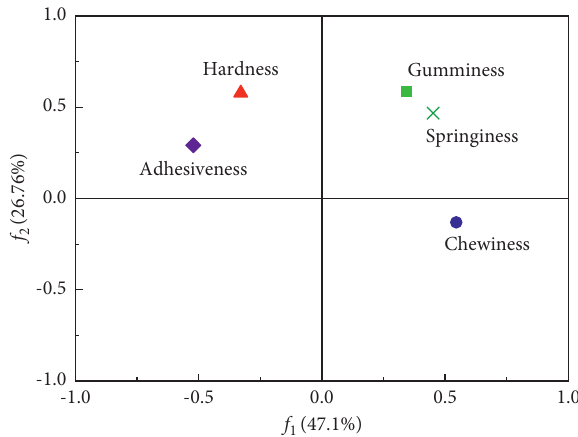
Figure 1: Biplot of the principal component analysis for the texture profile analysis.